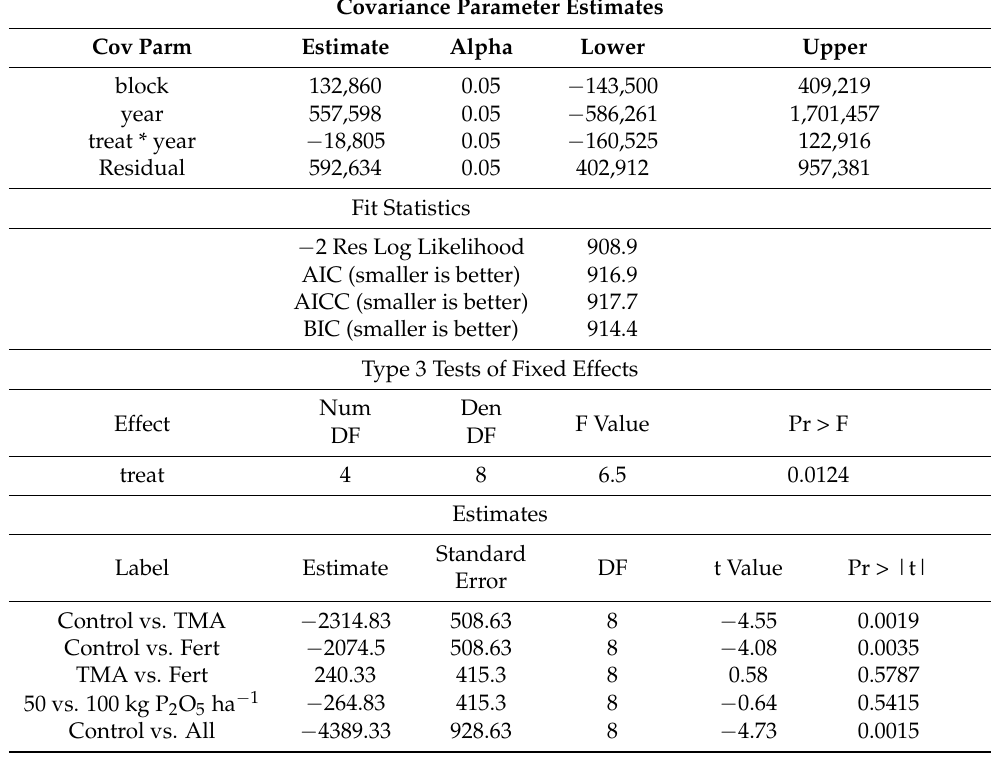
Table 2. Output 2: Partial output of the statistical analysis of the corn study when year was treated as a random